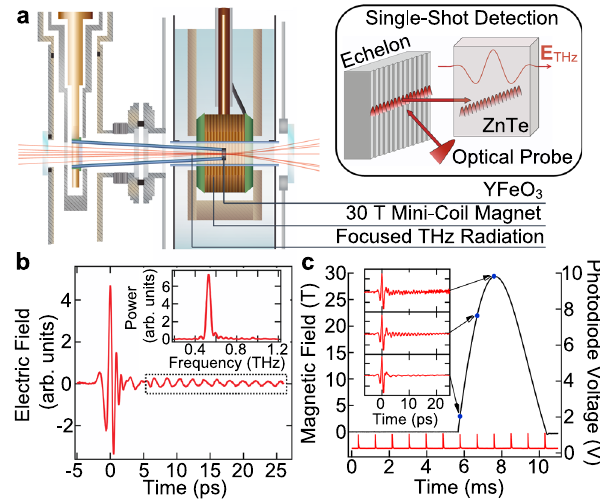
Fig. 1 Unique combination of table-top, 30 T pulsed magnet and single- shot THz detection. a Schematic of pulsed magnet surrounding single crystals of YFeO 3 . Note that although the sample is held on a sapphire pipe mounted on the cold fi nger of a liquid helium cryostat, no liquid helium was used in this study. Single-shot detection (shown in inset) is based on a combination of a zinc telluride (ZnTe) crystal and a unique re fl ective echelon. b Sample THz electric fi eld waveform transmitted through a YFeO 3 crystal. Time-domain oscillations for t > 0 from coherent spin precessions (magnons) are Fourier transformed to yield the magnon frequency (inset). c Pulsed magnetic fi eld pro fi le (solid black line), optical pulses used to generate/detect THz waveforms (solid red line), and sampled magnetic fi eld strengths (blue dots) with transmitted THz waveforms measured at the sampled magnetic fi eld strength shown in the inset. The optical pulses are detected using a photodiode that measures scattered